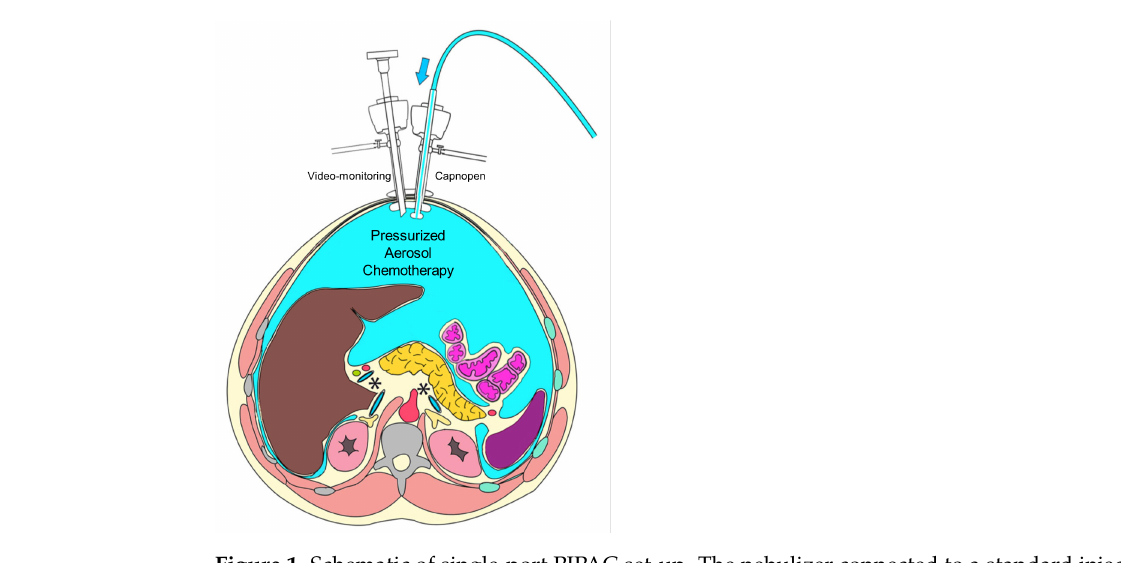
Figure 1. Schematic of single-port PIPAC set-up. The nebulizer connected to a standard injector and a laparoscope are inserted through a Quadport+